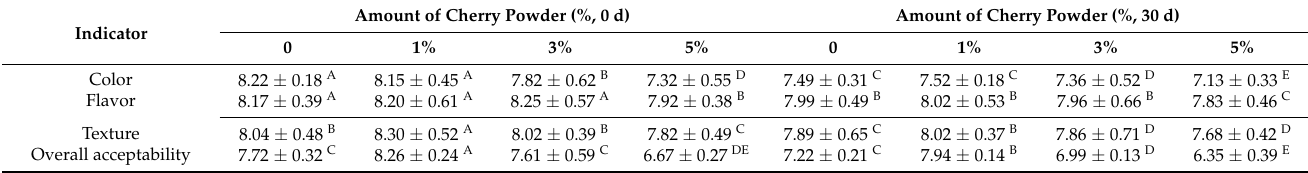
Table 2. Effects of cherry powder addition on sensory attributes of Jiangsu-type sausage during